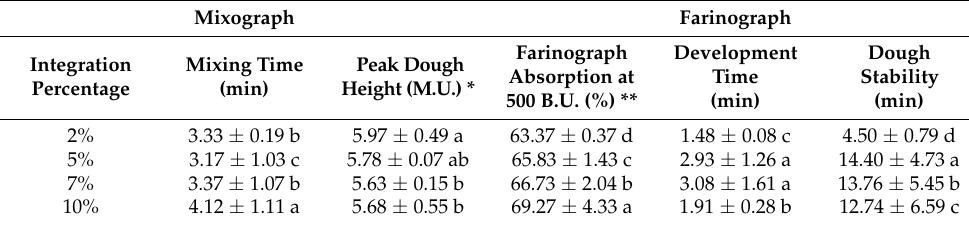
Table 6. Main technological parameters: two-factor ANOVA (analysis of variance) referred to the different percentages of integration of two flours (data are means ± standard